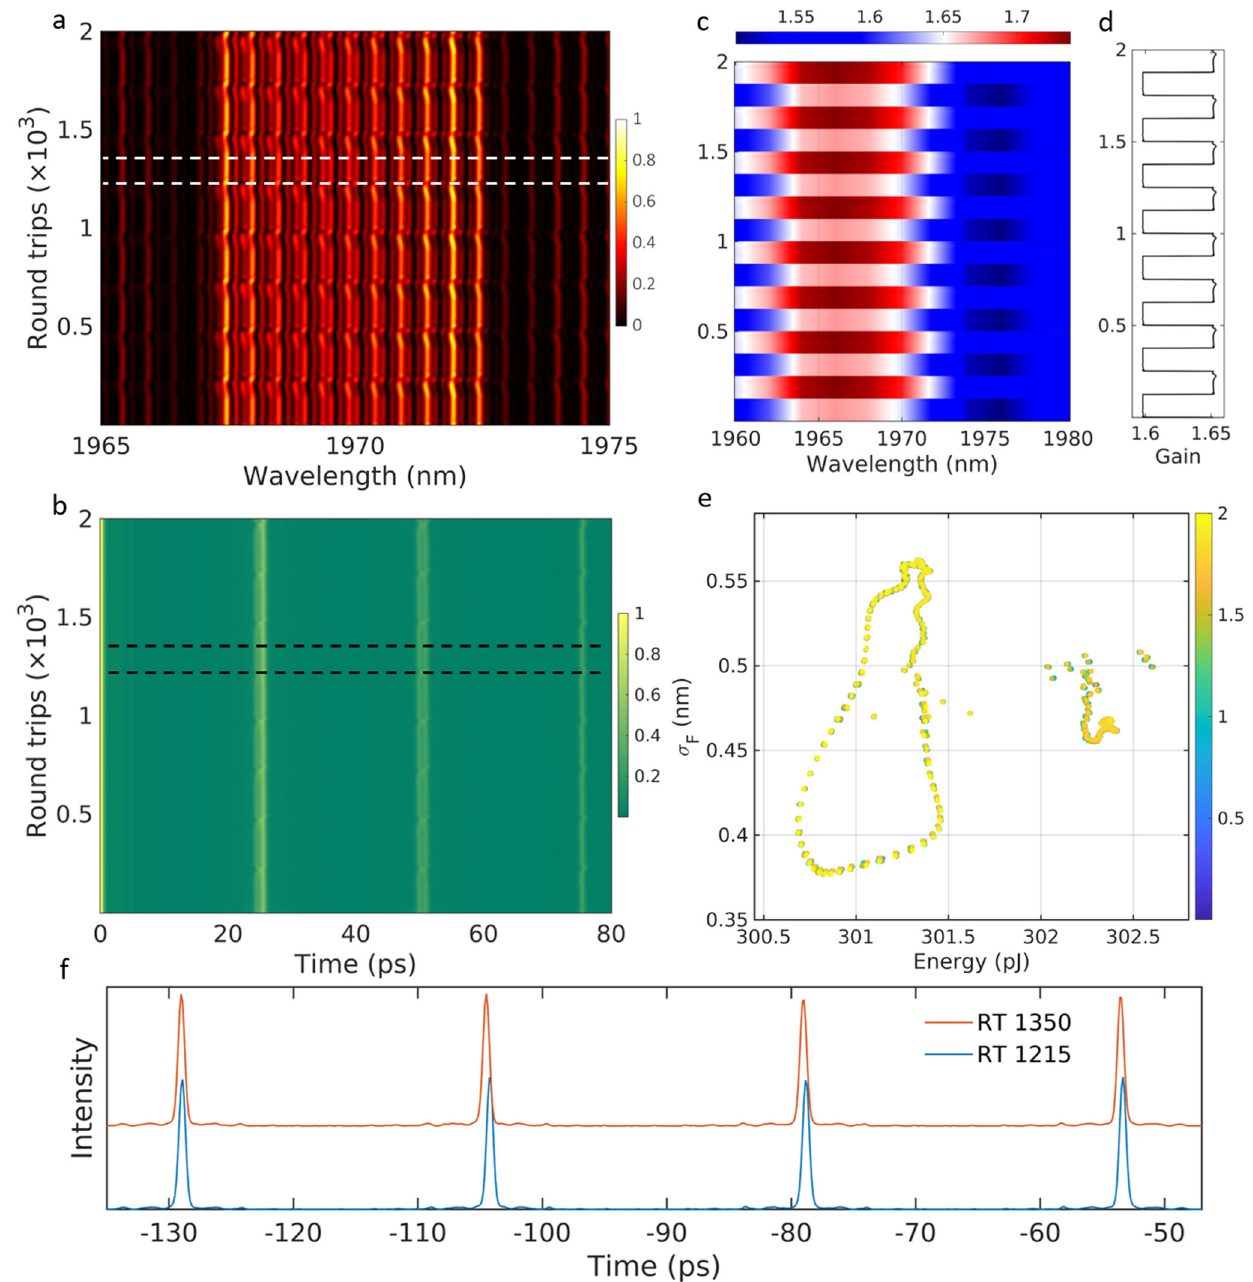
Fig. 6 Simulations of periodic switching of soliton quartet molecule with dual-stability. Evolution of a Spectrum and b corresponding fi eld autocorrelation traces. c Color map of the net gain coef fi cient variation with the number of cavity roundtrips. d Roundtrip dependent means by averaging the net gain coef fi cients ranging from 1960 to 1980 nm. e evolving trajectories in the plane constructed by the square root of the spectra moment and pulse energy. f The temporal pulse distribution of several typical RTs corresponds to the black dashed lines in ( b